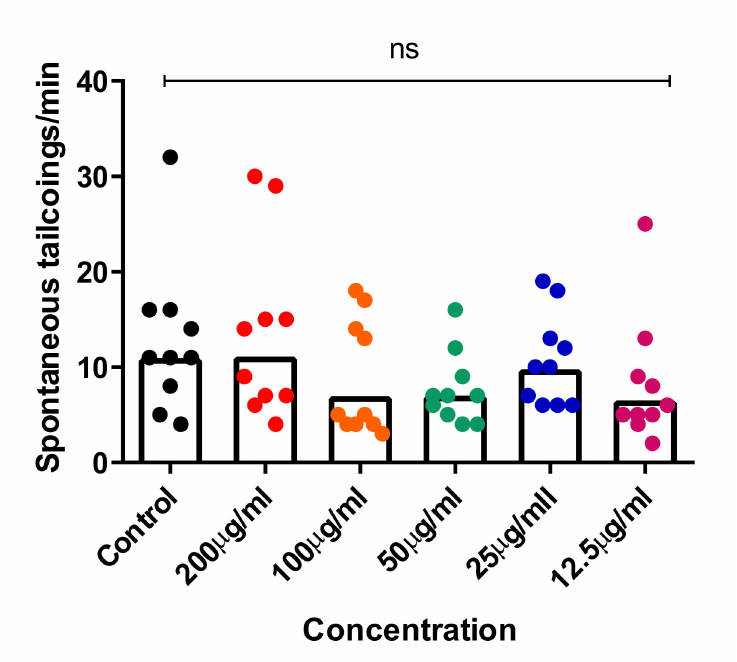
Figure 17. Tail-coiling rate in zebrafish embryos exposed to CTF_EA at different concentrations (200 µ g/mL, 100 µ g/mL, 50 µ g/mL, 25 µ g/mL, and 12.5 µ g/mL) at 24 hpf developmental stage. Each dot represents the number of spontaneous tail coils per individual animal ( n = 10 for each concentration). Mean values were expressed as bar graphs; ns means not significant.